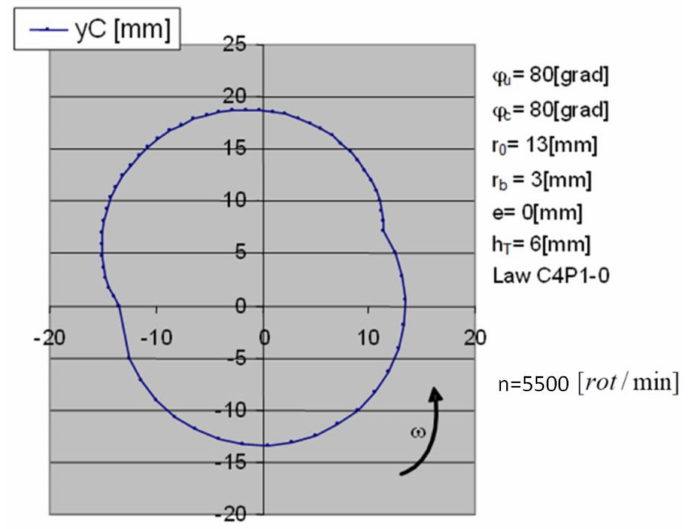
Figure 17. Cam profile at module B. C4P law, n = 5500 [rot/min] ϕ u = 80 [degree], r 0 = 13 [mm], r b = 3 [mm], h T = 6